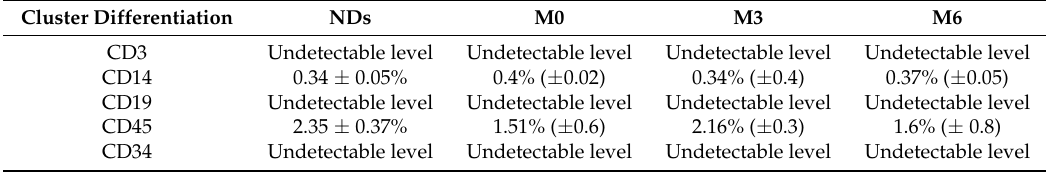
Table 3. Cell phenotype of CPCs (Circulating Progenitor Cells) after